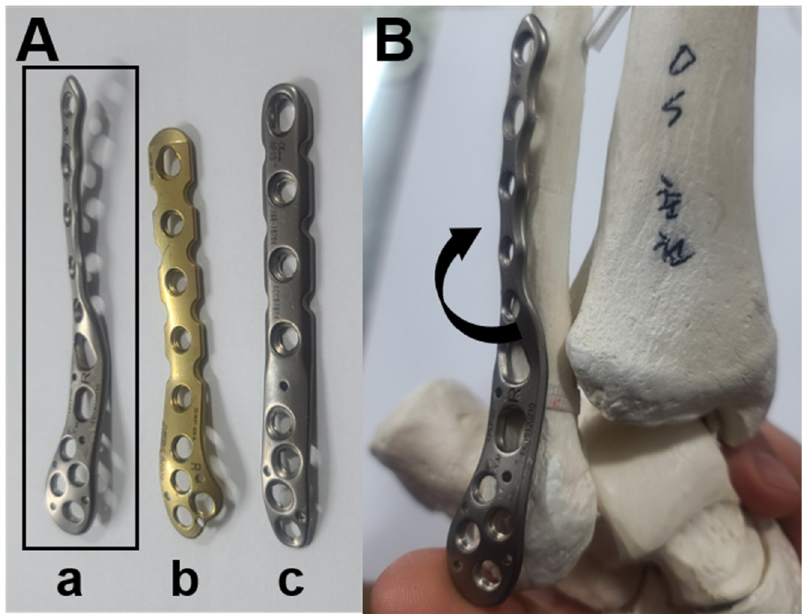
Figure 3. ( A ) Morphology of the three-dimensionally pre-contoured locking plate (a) compared to two-dimensionally pre-contoured locking plates (b,c). ( B ) Considering the interosseous crest of the fibula, the proximal portion of the plate is twisted posteriorly and can be fit anatomically on the bone contour.